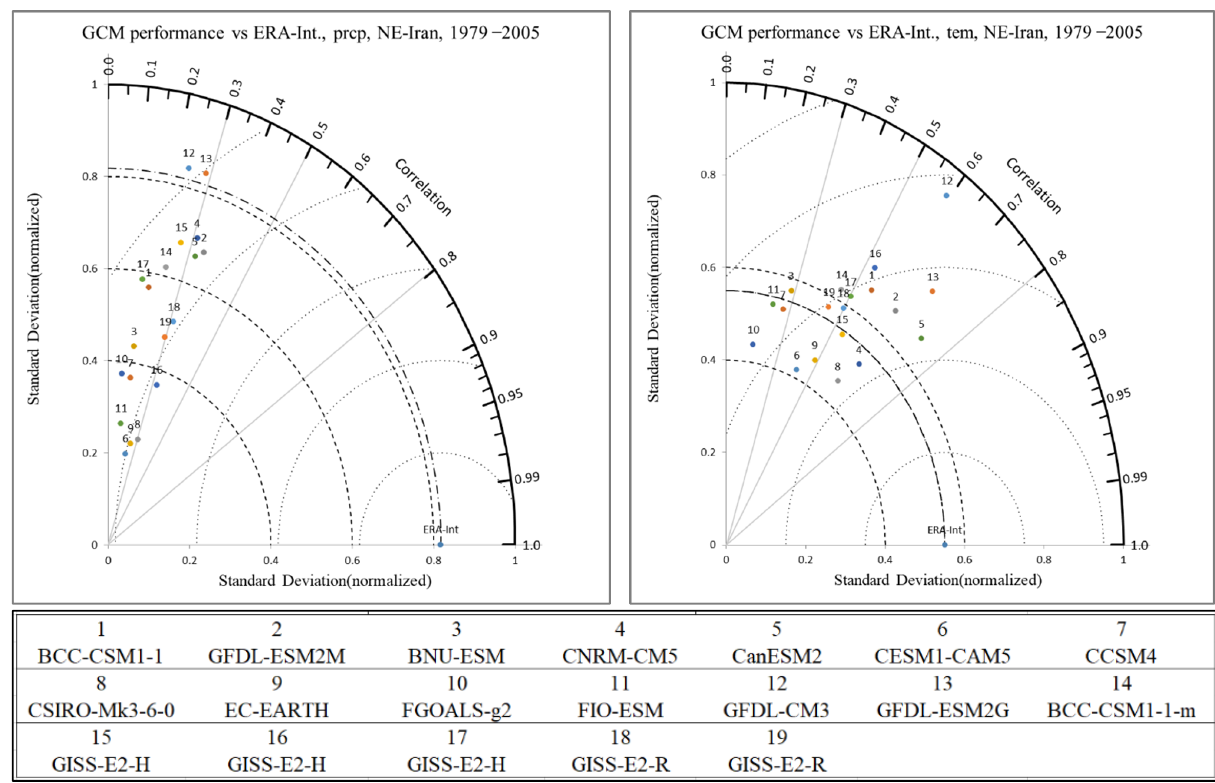
Figure 3. Taylor diagram showing performance of 19 GCMs (listed in the bottom of the figure) for precipitation ( left ) and temperature ( right ) during 1979–2005 with comparing ERA-interim data (blue-colored dot on the horizontal axis) with historical data of GCMs.